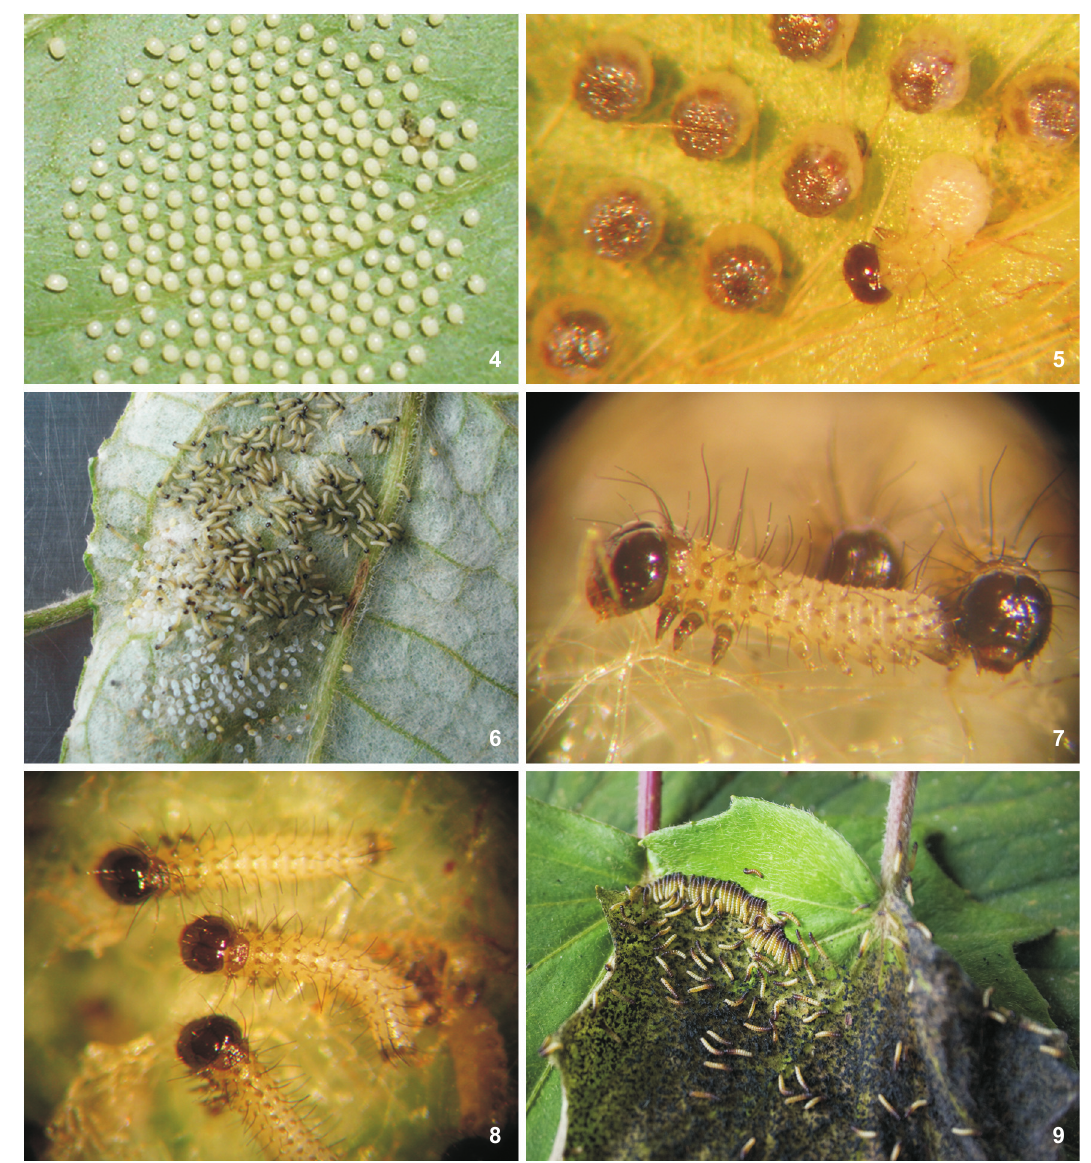
scoli are creamy yellow. The other scoli vary from brown to creamy yellow. The scoli setae range from chestnut and creamy yellow to